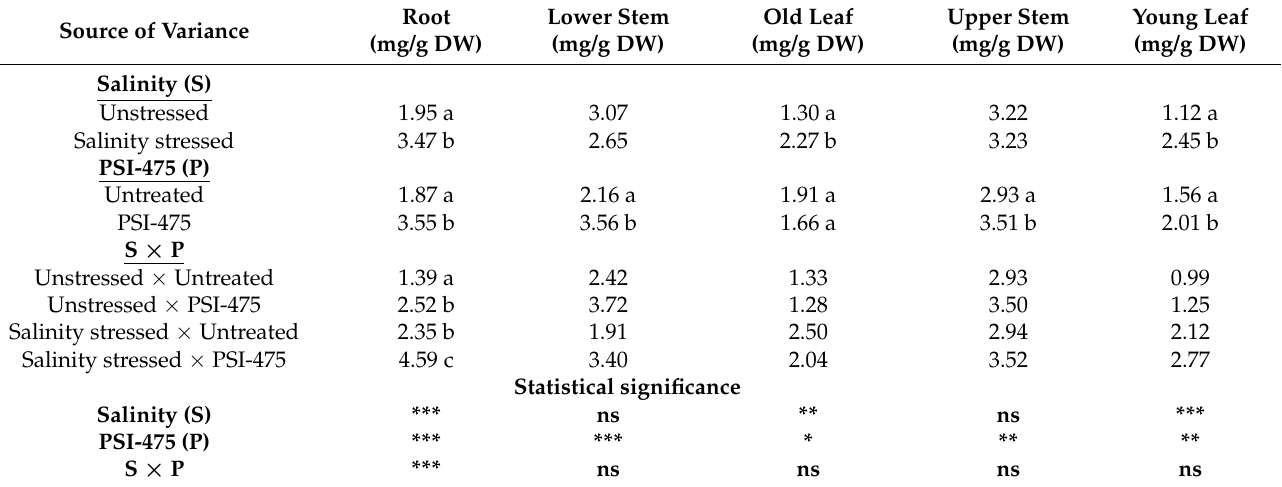
Table 5. Effect of salinity stress and PSI-475 on sucrose content in different tomato plant